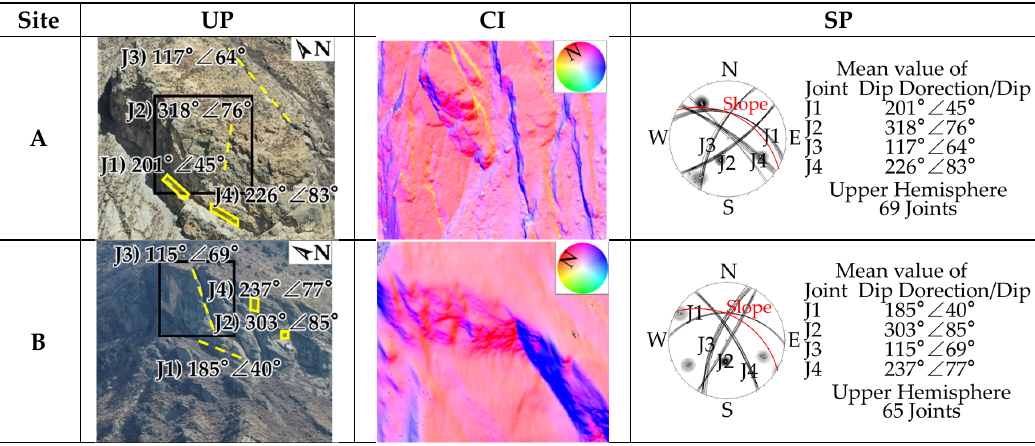
Figure 5. UAV photos of the two site investigation areas (UP) (see Figure 1b for locations), Coltop images in colors representing the local orientation (CI) and stereographic projection (SP).